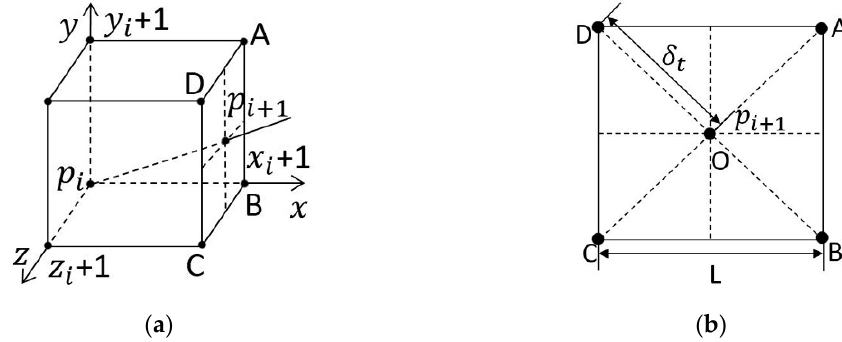
Figure 8. The maximum theoretical error of a spatial straight line. ( a ) A straight line in a unit grid. ( b ) The position of the maximum theoretical error point in the plane.